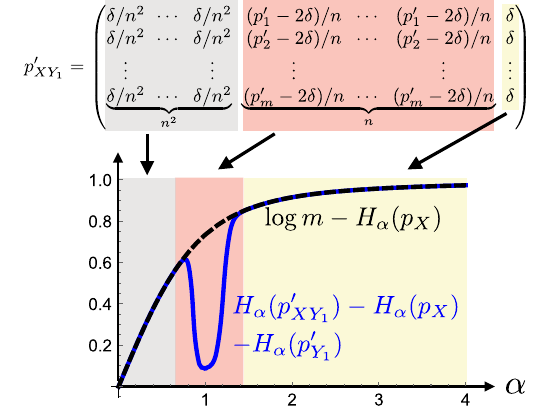
FIG. 4. The extension p 0 of p 0 that is used in the main XY 1 X text to establish sufficiency of the entropy conditions in the main theorem. According to Eq. (7), the goal is to build an extension such that the blue curve (that is, the α -R´enyi entropy balance) attains only positive values. The plot is for m ¼ 3 , 91 δ ¼ 10 − 3 , p ¼ p ; 1 ; 1 , Y 1 ¼ R n 2 þ n þ 1 with n ¼ 10 15 , 100 20 25 Þ X ¼ ð and p 0 ¼ p 0 ¼ ð 17 20 ; 7 50 ; 1 100 Þ . Since H α ð p Þ > H α ð p 0 Þ for 0 < α ≤ 1 3 , X there does not exist c such that Eq. (5) holds true; i.e., no M standard catalytic thermal operation can transform p into p 0 . Nevertheless, the transition can be achieved by a correlating catalytic thermal operation. The shaded colors show how differ- ent entries of p 0 are responsible for (the positivity of) different XY 1 parts of the curve, as explained in the main text. In the limit n → ∞ , only positivity at α ¼ 1 , i.e., positive balance of Shannon entropy, remains as a necessary